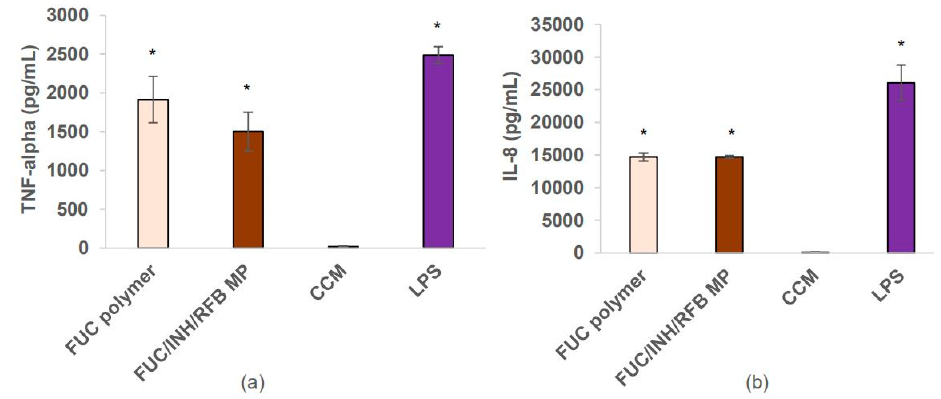
Figure 7. Assessment of ( a ) TNF- α and ( b ) IL-8 secretion induced by FUC/INH/RFB microparticles and FUC as the raw material. Lipopolysaccharide (LPS) and cell culture medium (CCM) were used as controls. FUC: fucoidan; INH: isoniazid; RFB: rifabutin. Data represent mean ± SEM ( n = 3). * p < 0.05 compared to CCM.